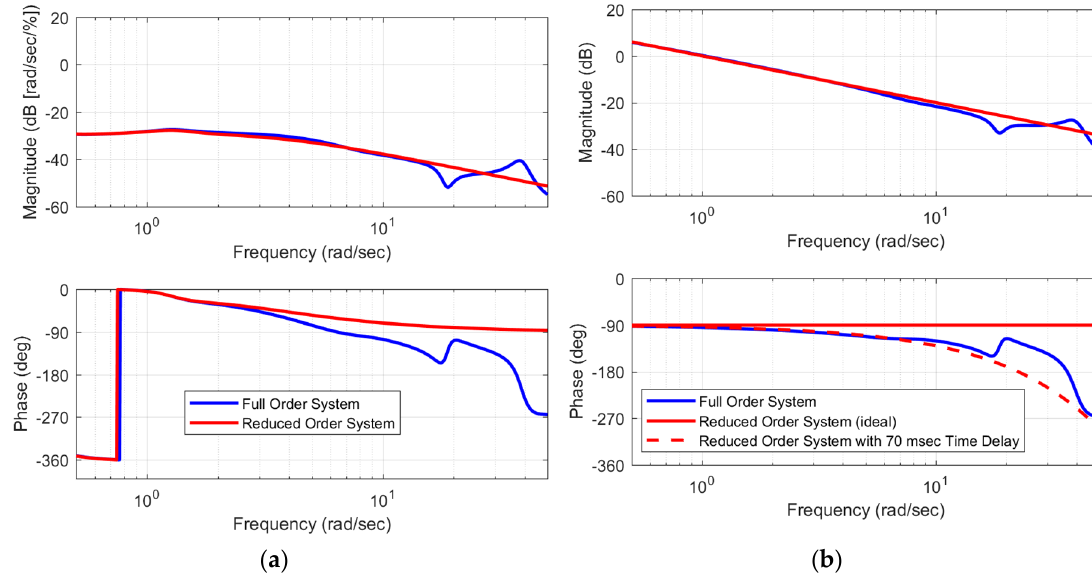
Figure 8. Frequency responses of helicopter linear models at 80 kts: ( a ) open loop roll rate response to lateral cyclic input, full order and reduced order models; ( b ) response of roll rate to lateral pseudo-command with feedback linearization loop closed, full order system, reduced order system (which represents an ideal integrator response), and reduced order system with a time delay (which represents a reasonable approximation of the full order system up to 15 rad/s).